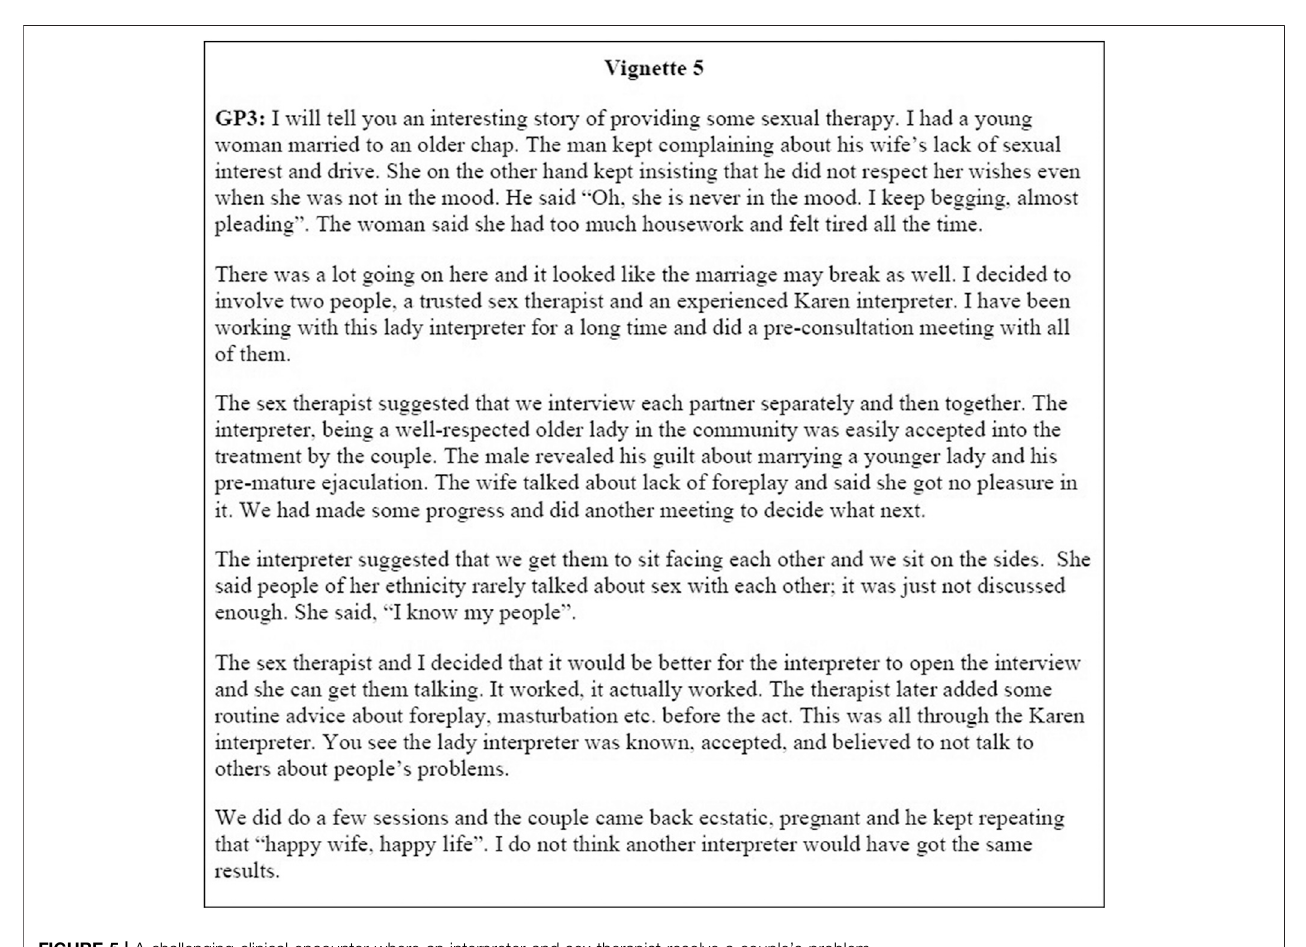
subthemes ( Table 2 : Themes and sub-themes) . The two themes “ Negotiating language and vocabulary ” and “ Interpretation related issues ” are considered together for